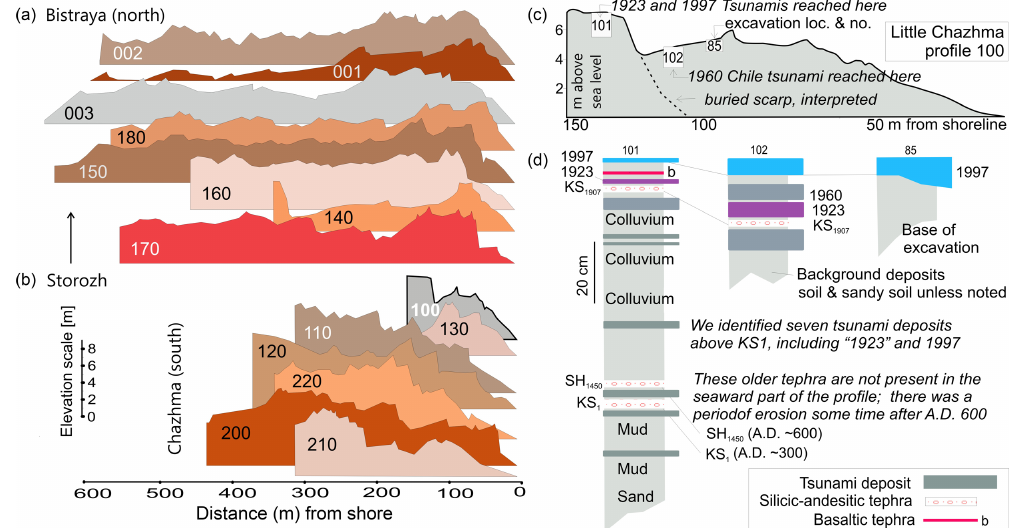
Figure 4. (a, b) Topographic profiles measured in southern Kamchatsky Bay (locations in Fig. 1, arranged from south (b) to north (a) , except 001 and 002 reversed to reveal topography. Distances and elevations are measured from 0 at the water line (lower right corner of each profile), corrected to high tide. (c, d) Chazhma profile 100 used as a key to collected profile data and interpretations (interpretations in italics); background deposits are soil or sandy soil, unless otherwise